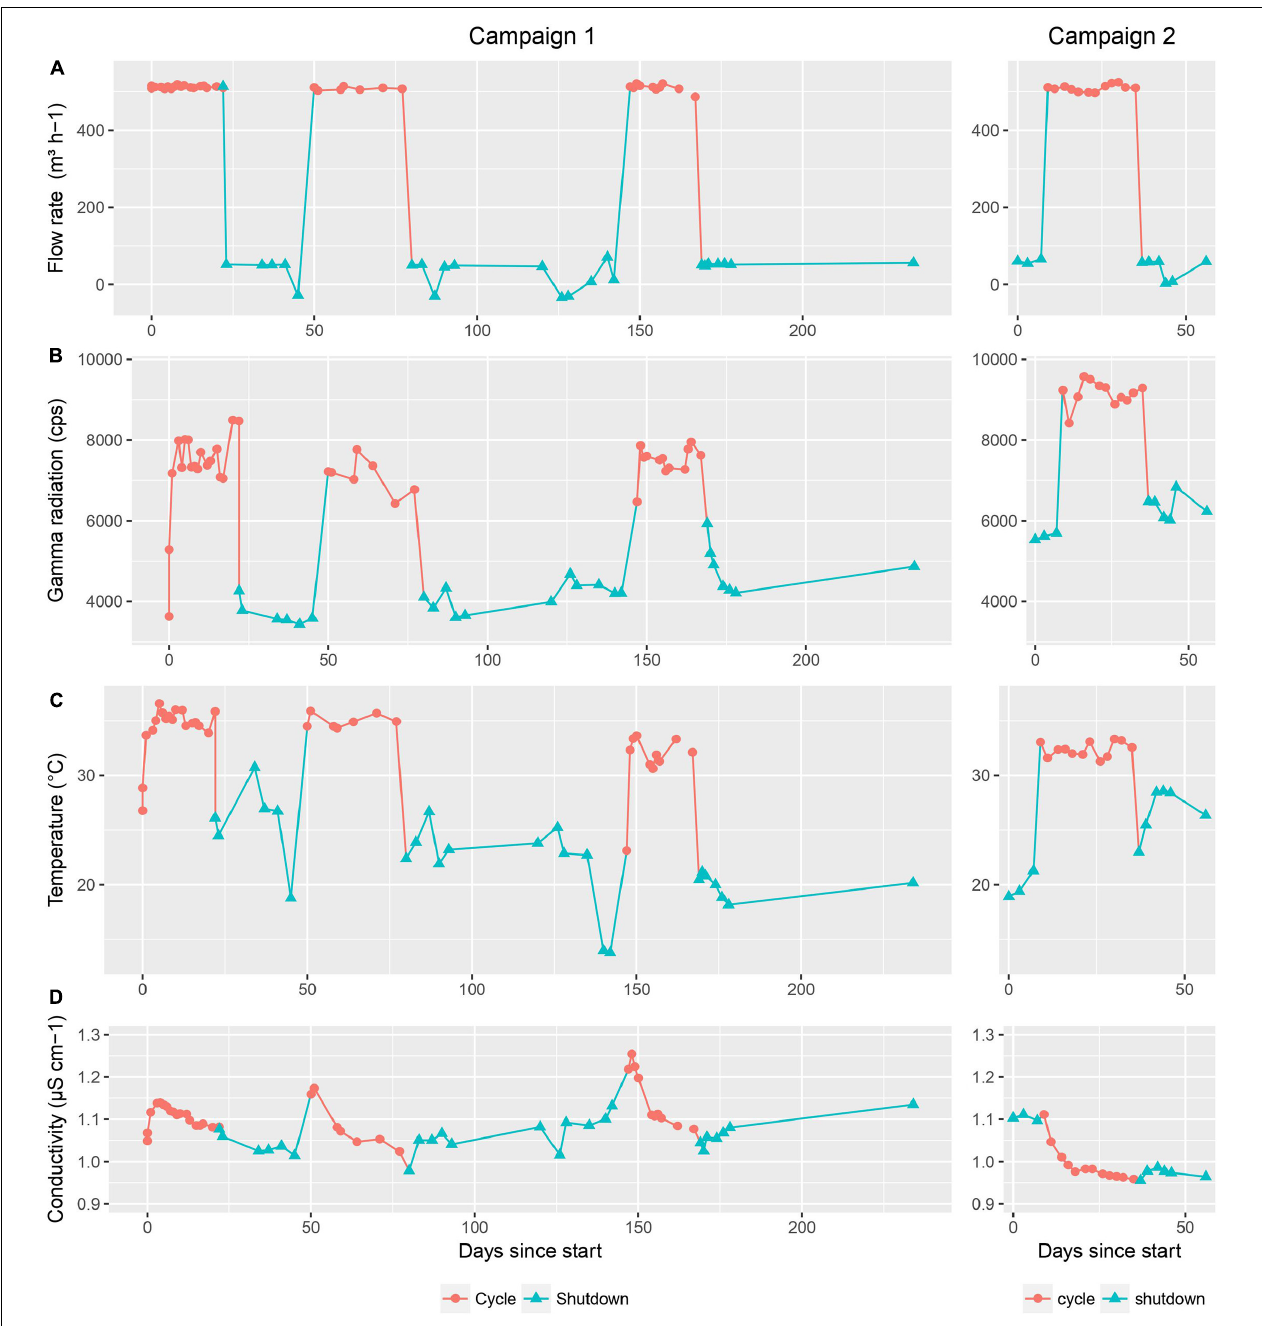
FIGURE 1 | Physical parameters monitored during the first and second sampling campaign. (A) flow rate in the basin cooling circuit (m 3 h − 1 ), (B) gamma radiation in the basin water (cps), (C) temperature in the basin water ( ◦ C). and (D) conductivity of the basin water ( µ S cm − 1 ). Cycle and shutdown periods are indicated by red circles and blue triangles,